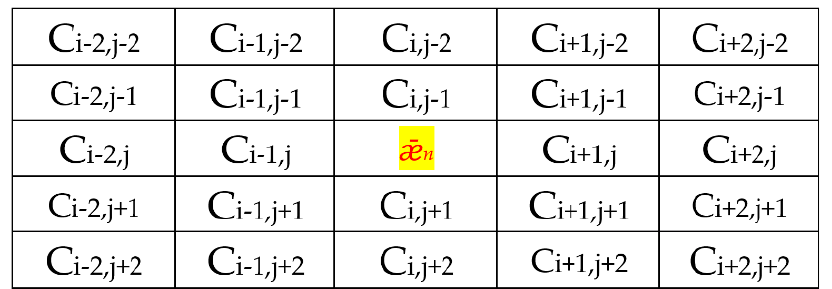
Figure 7. The dynamic matrix with 24 computational grid cells rendered in 16 directions for com ‐ puting of the ǣ values at the central viewpoints of the short ‐ range viewsheds of the ecotone habitats. ing of the ¯æ values at the central viewpoints of the short-range viewsheds of the ecotone habitats. (Drawn by Arvydas Urbis). (Drawn by Arvydas